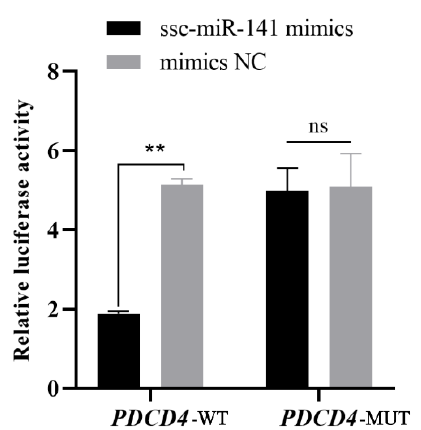
Figure 5. Double luciferase activity assays. Relative luciferase reporter expression was normalized to Negative control(NC). Each experiment was repeated three times. Data are presented as mean ± standard error. ** indicates p < 0.01 compared to mock NC; ns indicates no difference compared to mock NC (HEK-293T cells).